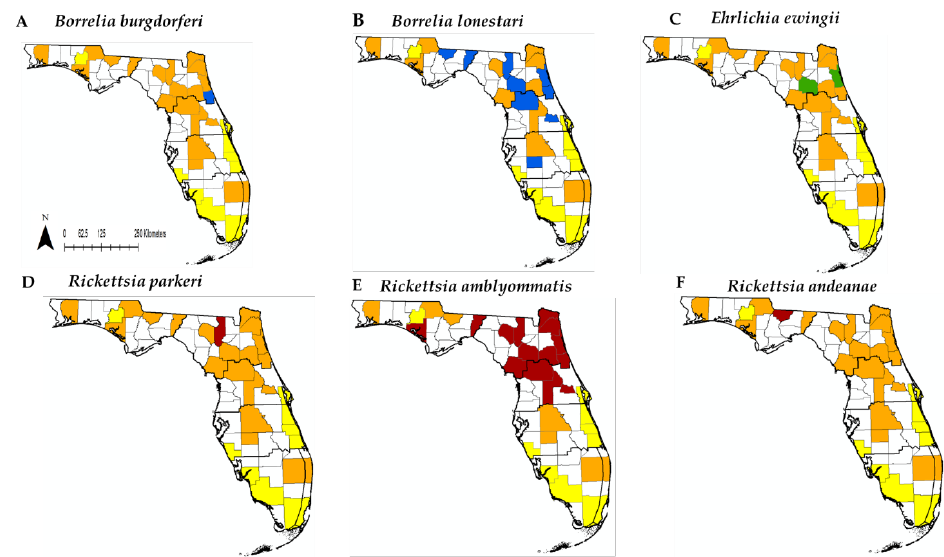
Figure 2. Florida counties where ticks were surveyed, and ticks that were positive for a bacterial species. Yellow = site surveyed but ticks not collected, Orange = counties where ticks were collected but were not infected with a bacterial species. Red/blue/green = county with positive ticks for a genus of bacterial species detected. Ixodes scapularis vectors: Thick black lines denote climatic regions. ( A ) B. burgdorferi . Amblyomma americanum vectors: ( B ) B. lonestari , ( C ) E. ewingii , ( D ) R. parkeri , ( E ) R. amblyommatis. Amblyomma maculatum vectors : ( F ) R. andeanae . Table 4. Pathogen prevalence of ticks collected from Spring 2016 through Fall 2018. * Most commonly reported BLAST result for each pathogen.